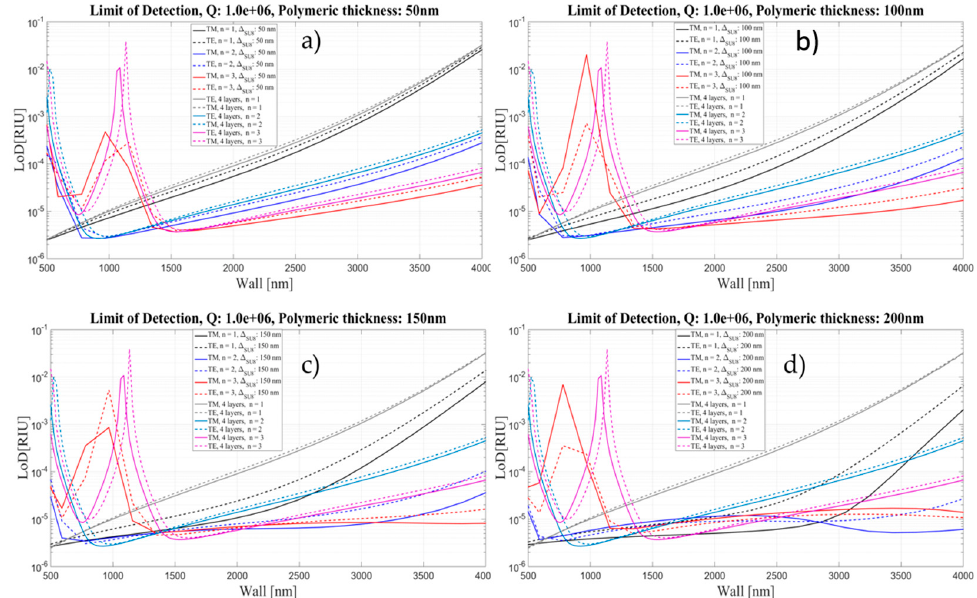
Figure 19. Limit of Detection for the four- and five-layer models as a function of Wall thickness for two different polarizations and three mode orders, corresponding to different thickness of polymeric layer: ( a ) 50 nm; ( b ) 100 nm; ( c ) 150 nm; and ( d ) 200 nm. Q is assumed to be about 10 6 .